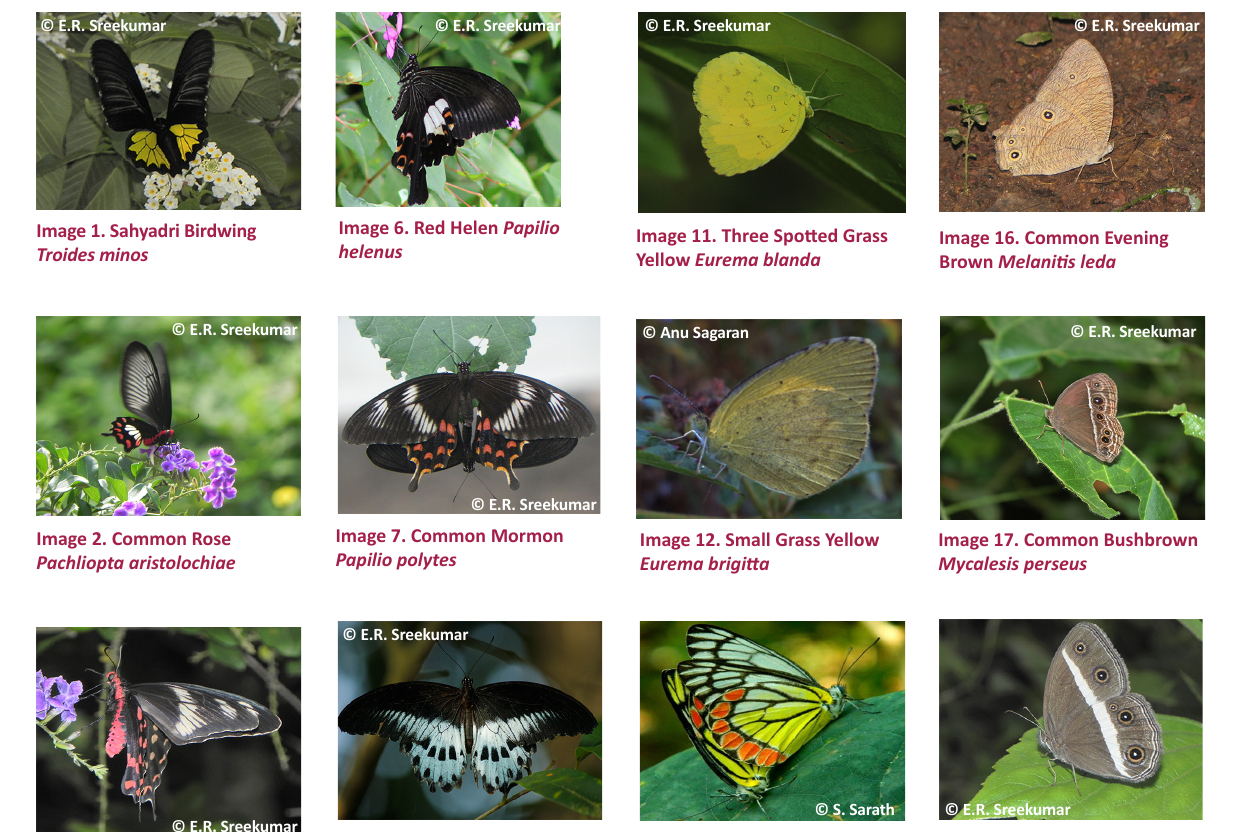
Image 13. Common Jezebel Delias eucharis